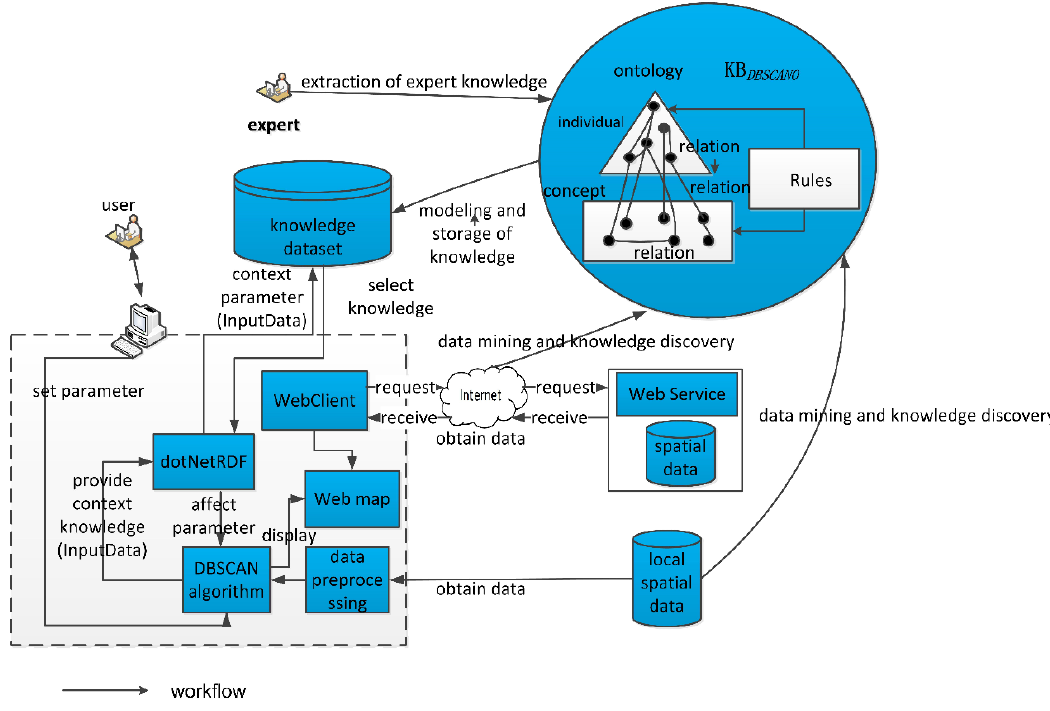
Figure 14. Process flow of the prototype.